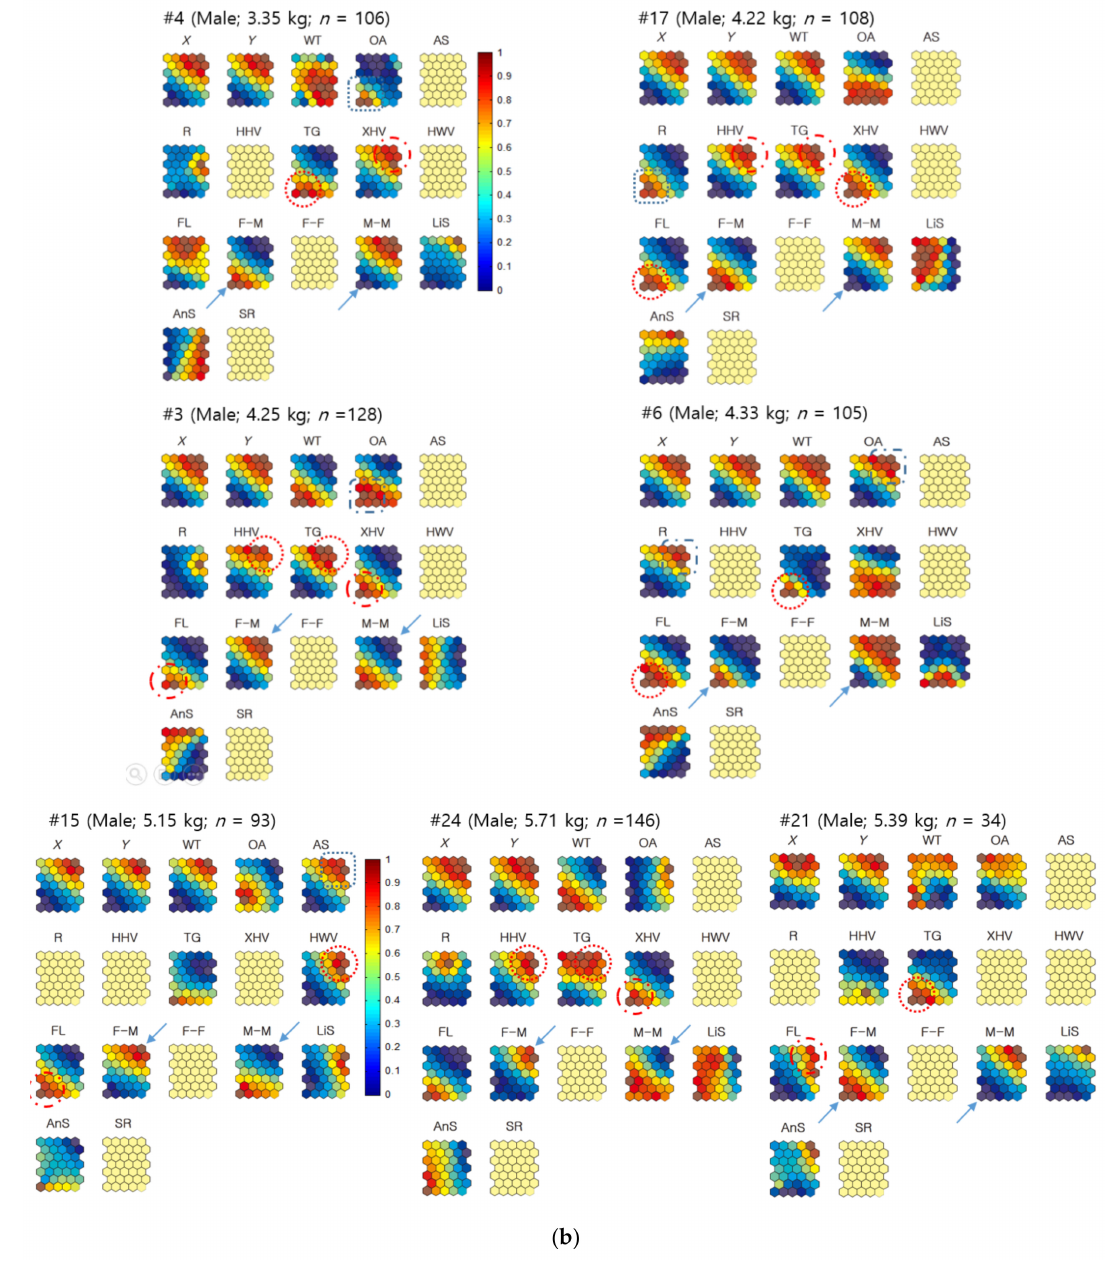
Figure 10. ( a ) Co-occurrence of nutria individuals within the 250 m distance in the Macdo wetland in association with environmental factors and biological data of the females. Values in all component maps were normalized between 0.0 and 1.0, as shown in the vertical bar. Blank component maps had no input value for the variables in each training. Abbreviations include: Water temperature: WT; open area: OA; artificial structure: AS; road: R; hydric herbaceous vegetation: HHV; tall grassland: TG; xeric herbaceous vegetation: XHV; hydric woody vegetation: HWV; floating-leaved hydrophytes: FL; sex ratio: SR; female–male co-occurrence: F-M; female–female co-occurrence: F-F; male–male co-occurrence: M-M; linear speed: LiS; angular speed: AnS. ( b ) Co-occurrence of nutria individuals within the 250 m distance in the Macdo wetland in association with environmental factors and biological data of the males. Values in all component maps were normalized between 0.0 and 1.0, as shown in the vertical bar. Blank component maps had no input value for the variables in each training. Water temperature: WT; open area: OA; artificial structure: AS; road: R; hydric herbaceous vegetation: HHV; tall grassland: TG; xeric herbaceous vegetation: XHV; hydric woody vegetation: HWV; floating-leaved hydrophytes: FL; sex ratio: SR; female–male co-occurrence: F-M; female–female co-occurrence: F-F; male–male co-occurrence: M-M; linear speed: LiS; angular speed: